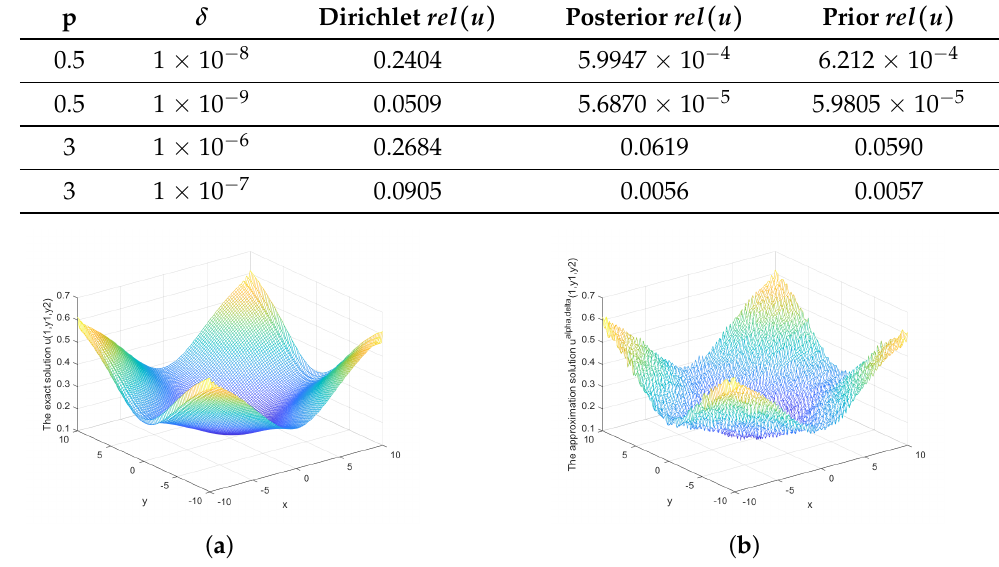
Figure 12. ( a ) The exact solution and ( b ) the regularized solution when x = 0.3, δ = 1 × 10 − 4 under a priori rule.